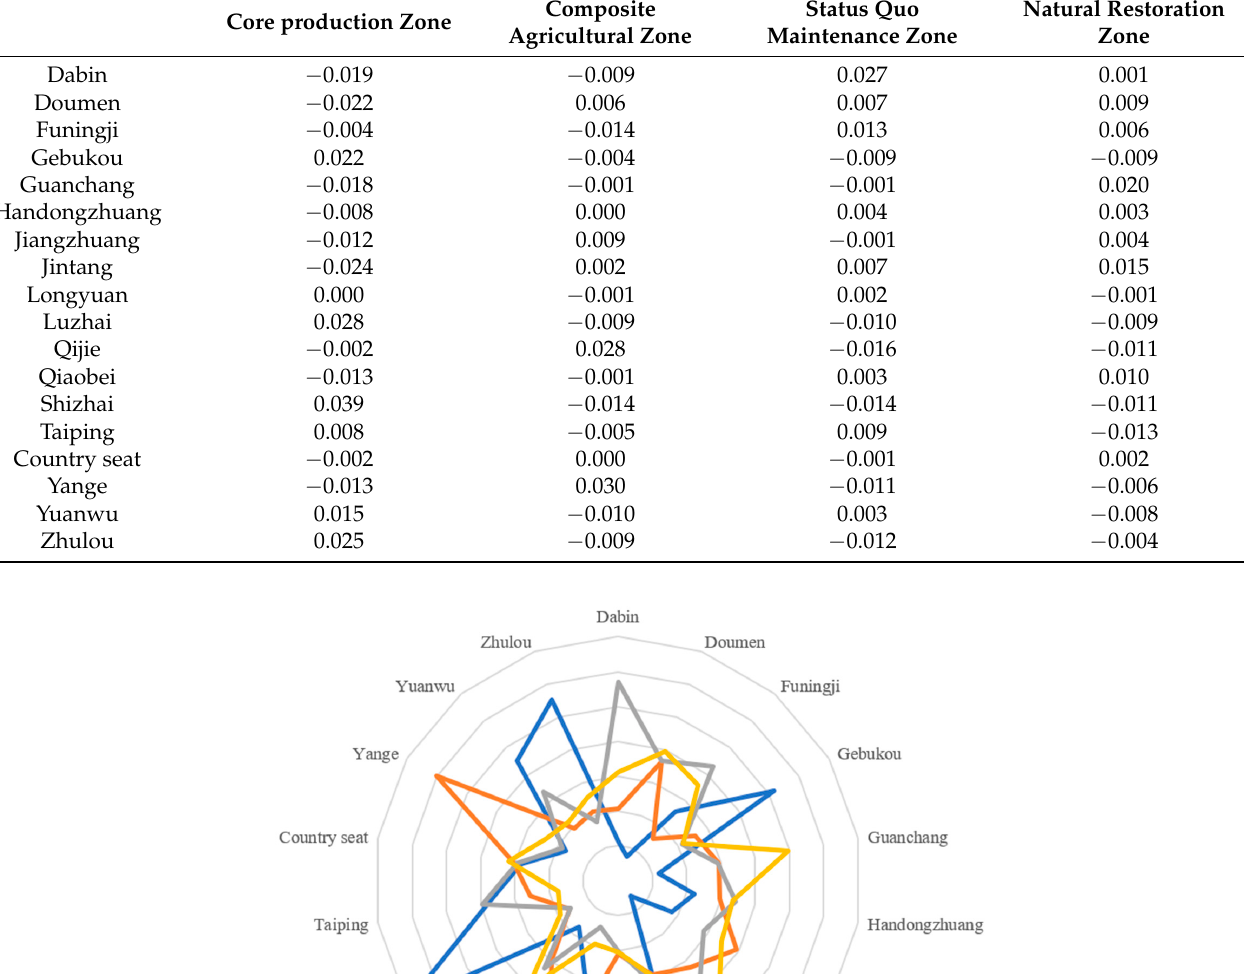
Table 5. Calculation results of the NRCA value of each township in Yuanyang County.